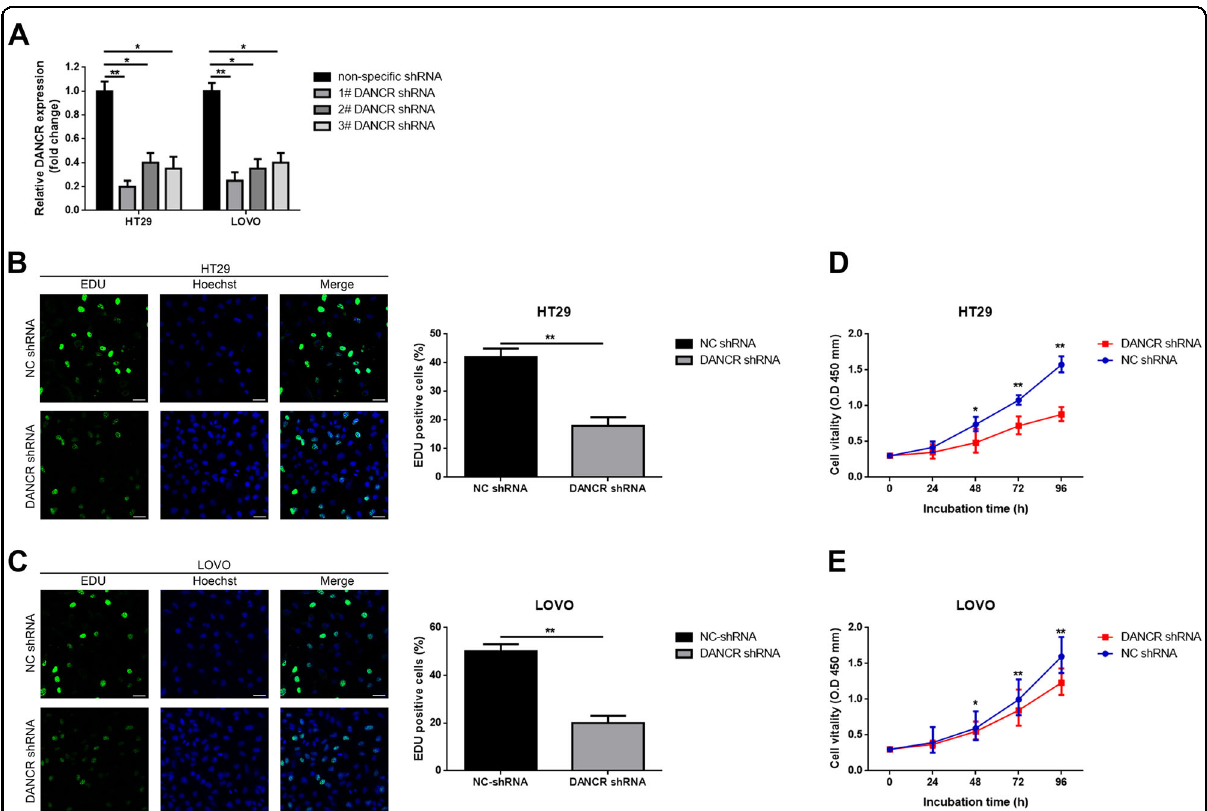
Fig. 2 Depression of DANCR inhibits the proliferation in CRC cells HT29 and LOVO. a Expression of DANCR was knocked down by transfection of DANCR shRNA and veri fi cation by qRT-PCR using GAPDH as the normalization control. * P < 0.05, ** P < 0.01 vs. the non-speci fi c shRNA group. b , c Depression of DANCR inhibited the proliferation ability in CRC cells HT29 and LOVO, as determined by 5-ethynyl-2 ′ -deoxyuridine (EDU) incorporation assays (Scale bar, 25 µm; magni fi cation, ×400). d , e Depression of DANCR suppressed the proliferation ability in CRC cells HT29 and LOVO, as determined by CCK-8 assays. ** P < 0.01 vs. the NC shRNA group. The data are shown as the means ± SD from three independent